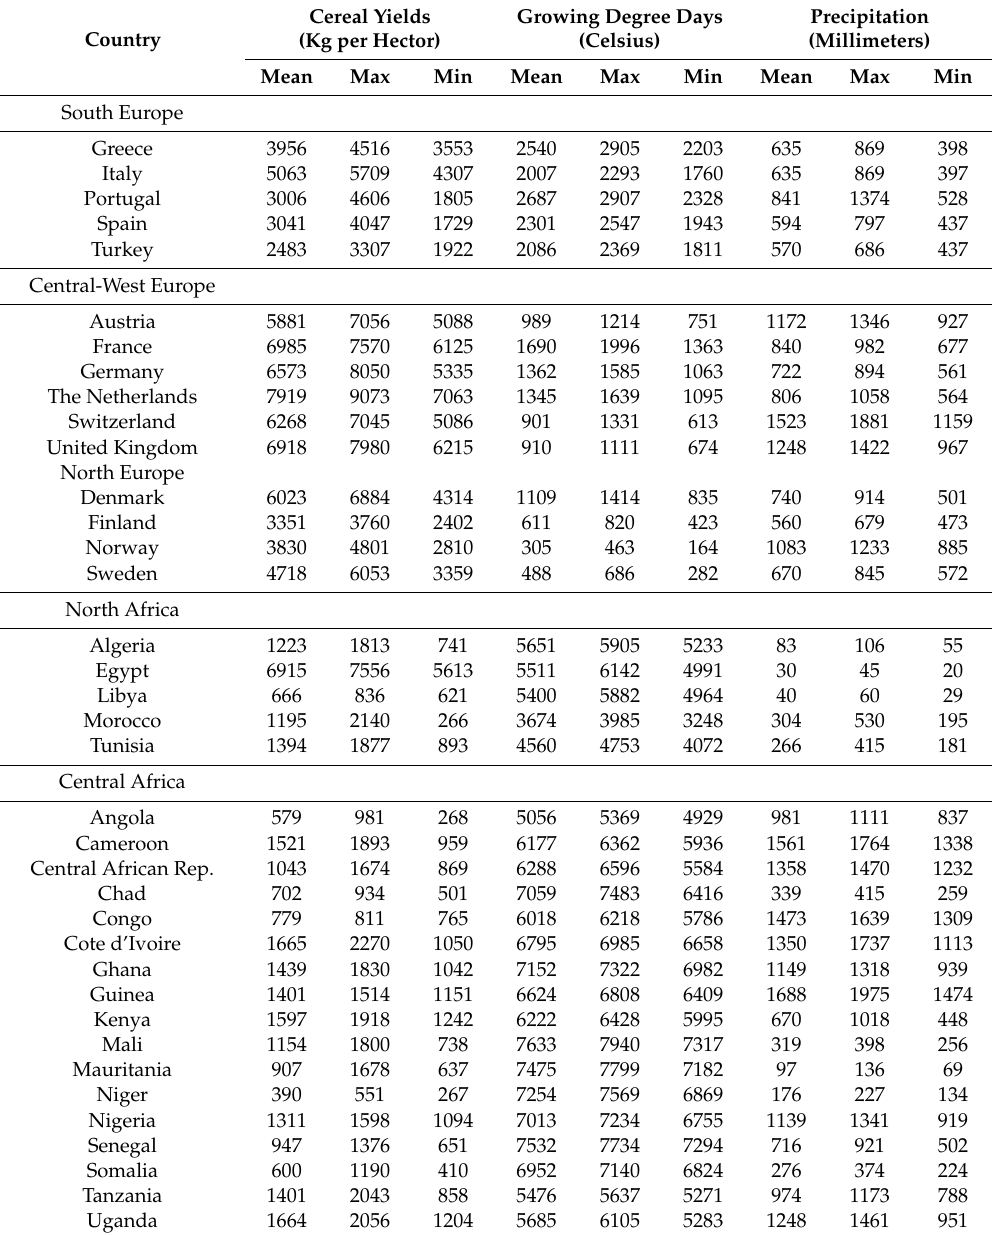
Table A1. Summary